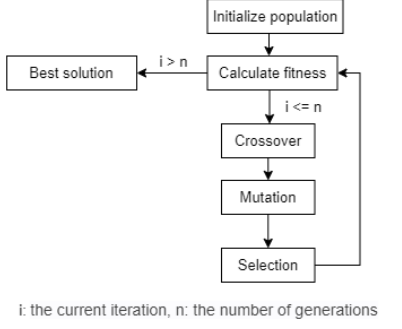
Figure 3. The flowchart of a genetic algorithm.